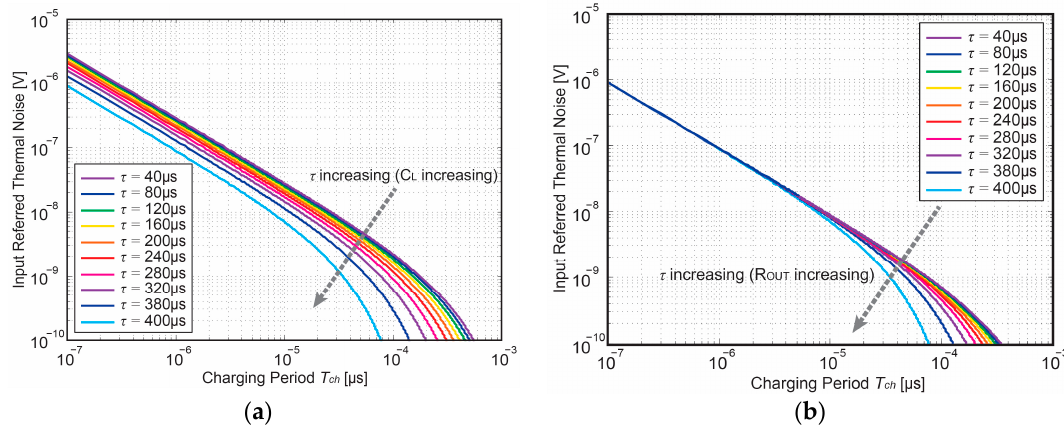
Figure 10. Input referred kTC noise as a function of charging period T ch during discharging phase ( a ) with τ and C L increasing ( b ) with τ and R OUT increasing.